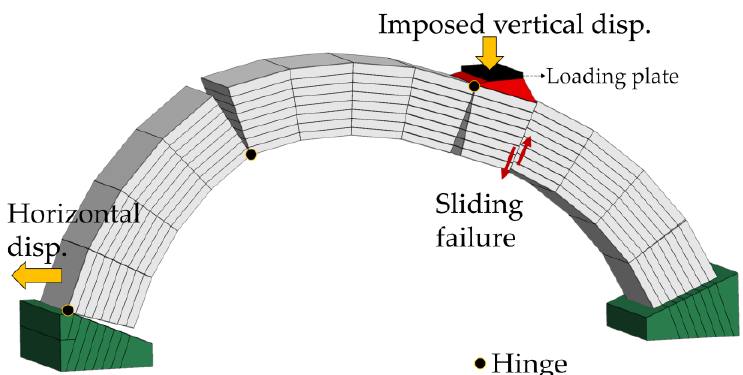
Figure 7. Collapse mechanism (three plastic hinges and sliding failure) obtained by discrete element model.